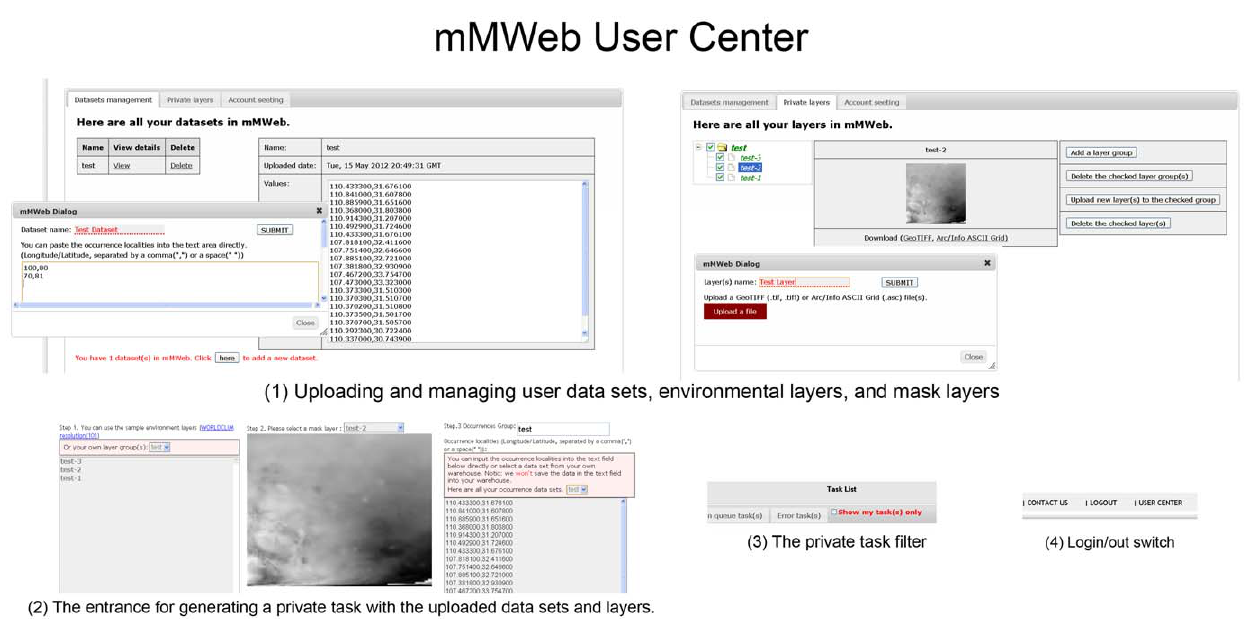
Figure 2. The User Center. The User Center includes the following functions: (1) Uploading and managing user data sets, environmental layers, and mask layers; (2) The entrance for generating a private task with the uploaded data sets and layers; (3) The private tasks filter; and (4) Login/out switch.